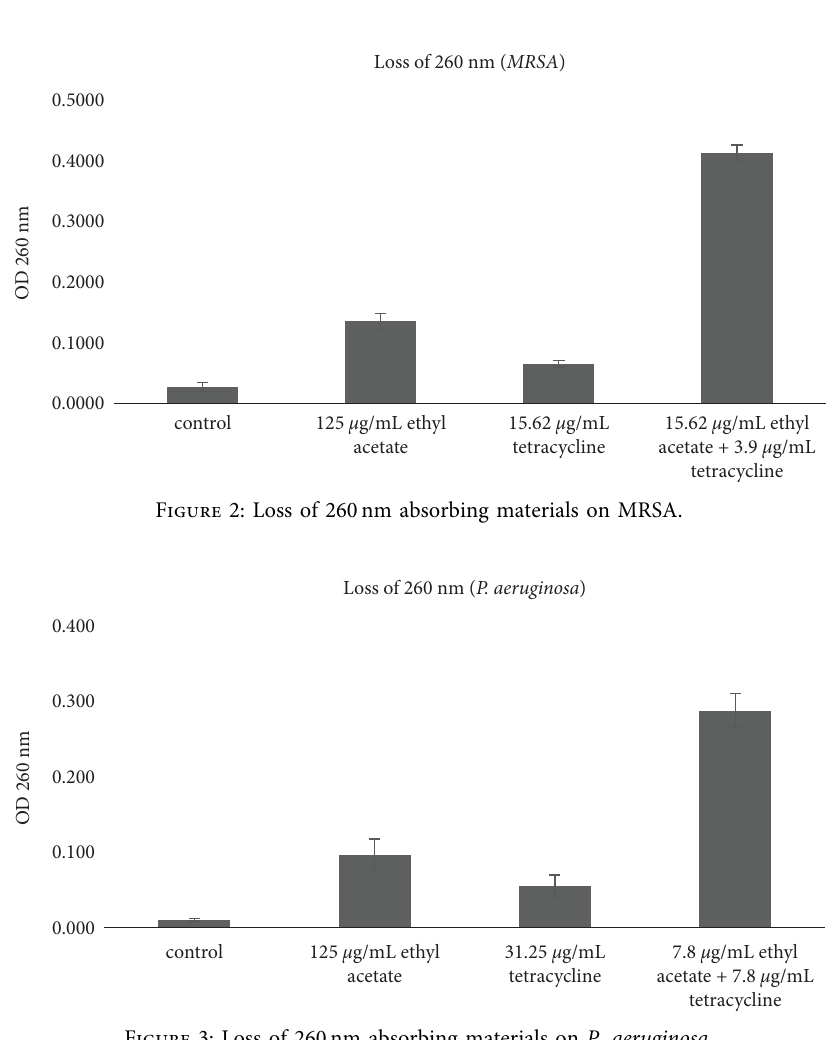
Figure 1: Isobologram of synergistic interaction between EAFVA and tetracycline against MRSA and P.aeruginosa.